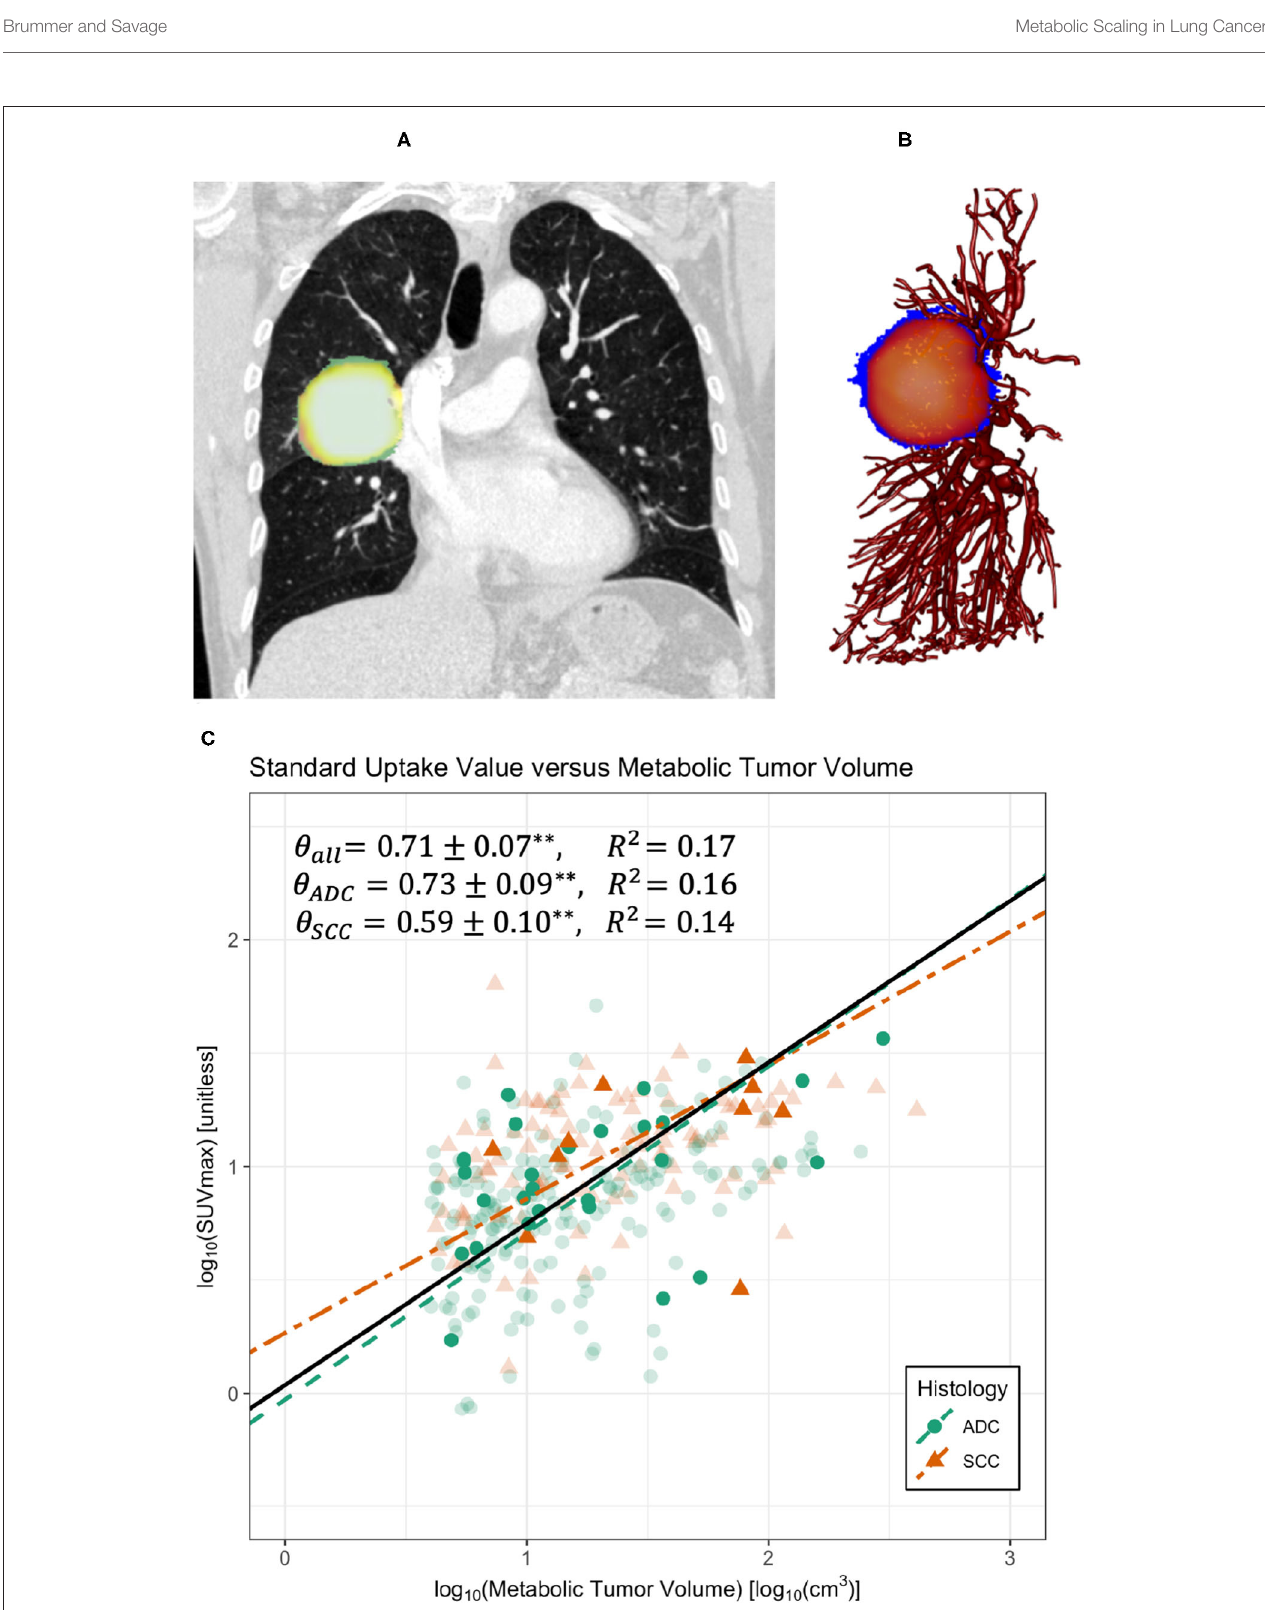
FIGURE 1 | Co-registered PET-CT images (A) and sample skeletonization of pulmonary vasculature with tumor (B) . (C) Regression on maximum standard uptake value ( SUV max ) and metabolic tumor volume ( MTV ) for all data compiled (black solid line), divided into the histological categories of adenocarcinoma (ADC) and squamous cell carcinoma (SCC). Regressions demonstrate a significant scaling relationship between SUV max and MTV with scaling exponents approximately equal to 0.71 ( Table 1 ). **Indicates p < 0.005. Bold symbols represent data with accompanying clinical imaging used in vascular analyses, whereas transparent symbols represent data collected without original clinical imaging. Data was truncated at MTV ≈ 4 cm 3 to avoid errors from the partial volume effect.